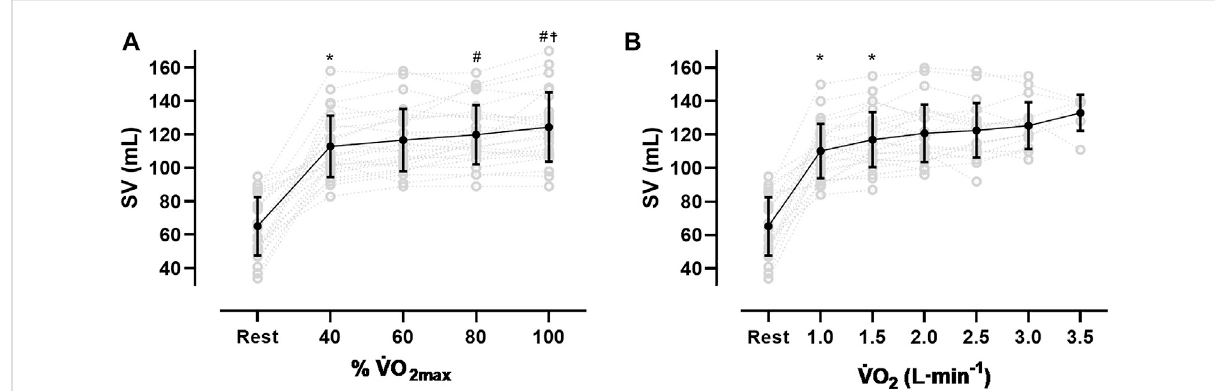
FIGURE 1 Strokevolume(SV)responsefromresttoV _ O 2max (A) andatthesameabsoluteV _ O 2 (B) ,*sig.comparedtopreviouscondition, # comparedto40% V _ O 2max , ☨ compared to 60% V _ O 2max